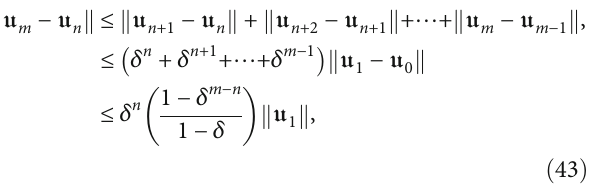
Figure 5: Example 2. (a) NTDM t = 0 : 5 and λ = 0 : 001